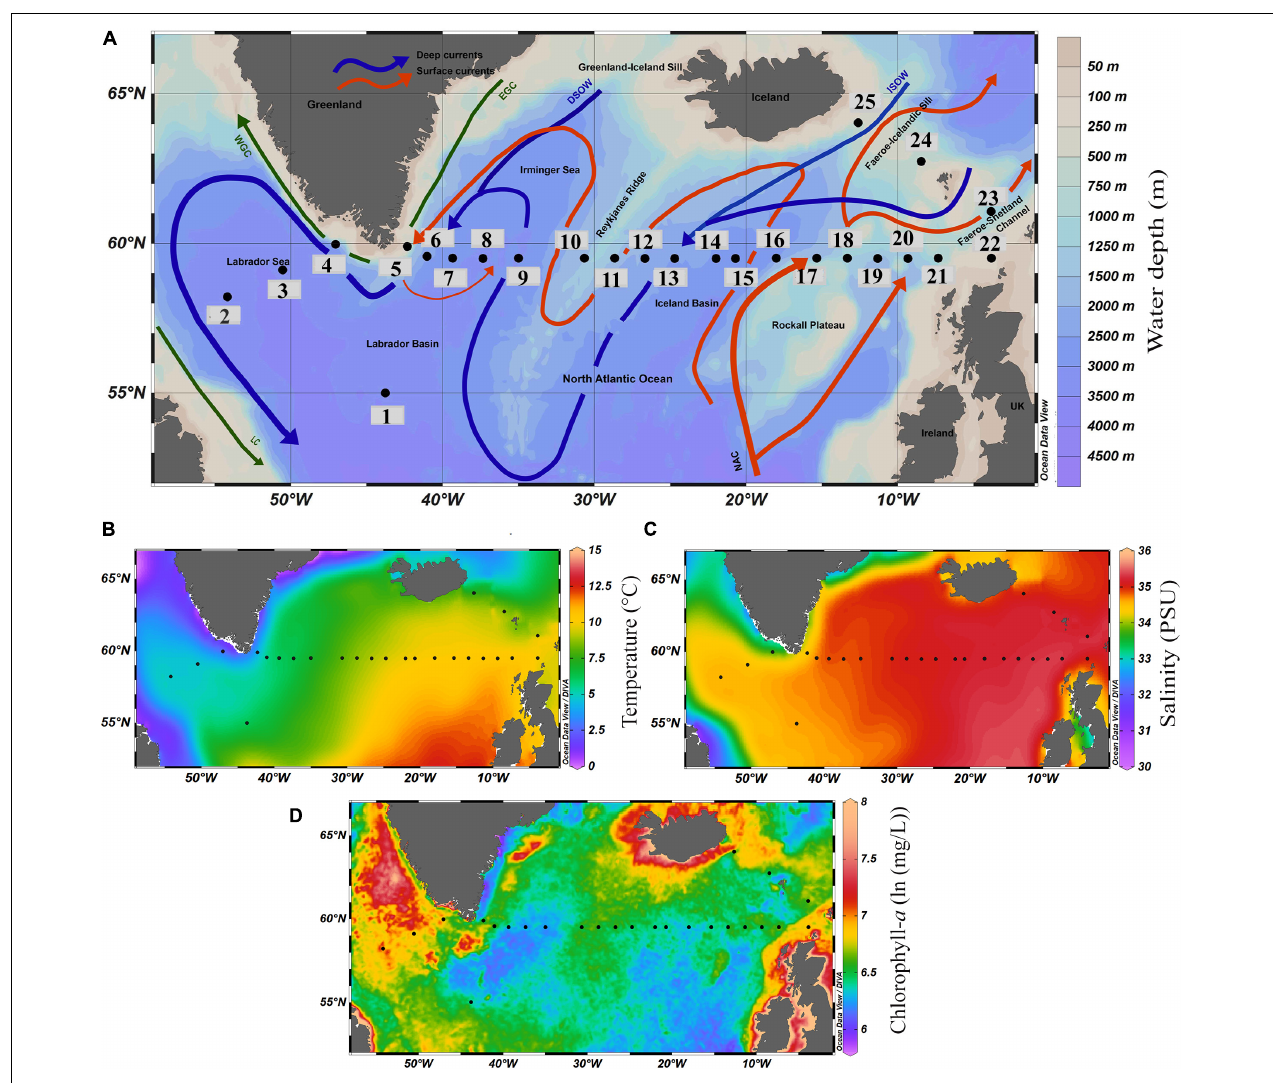
FIGURE 1 | (A) Map showing locations of surface sediment samples and major ocean currents in subpolar North Atlantic Ocean (Schlitzer, 2015). Total 25 samples along 59.50 ◦ N latitude were retrieved during Akademik Ioffe 51 cruise; the black dots represent the locations of the surface sediment samples and the numbers denote the name of the stations. Warm and cold surface currents are in red and green, respectively, and cold deep currents are shown in blue color. NAC, North Atlantic Current; EGC, East Greenland Current; WGC, West Greenland Current; ISOW, Iceland-Scotland Overflow water; DSOW, Denmark Strait Overflow Water; LC, Labrador Current; Map showing surficial distribution of, (B) Annual average Sea Surface Temperature (SST, ◦ C). (C) Annual average Sea Surface Salinity (SSS, PSU), and (D) Annual average Chlorophyll- a [ln (mg/L)] of the modern